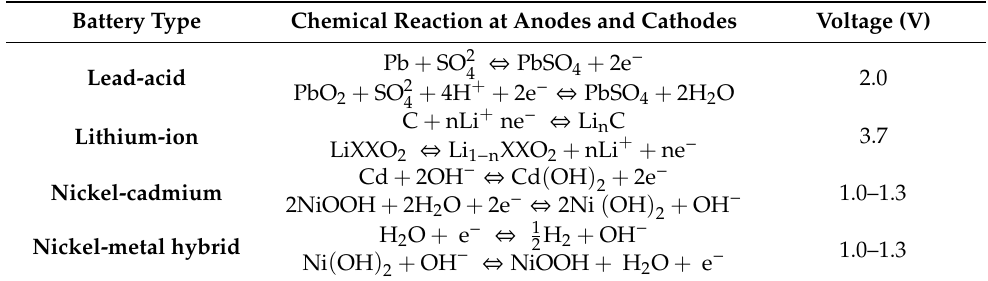
Table 2. Chemical reactions and single unit voltages of di ff erent battery systems